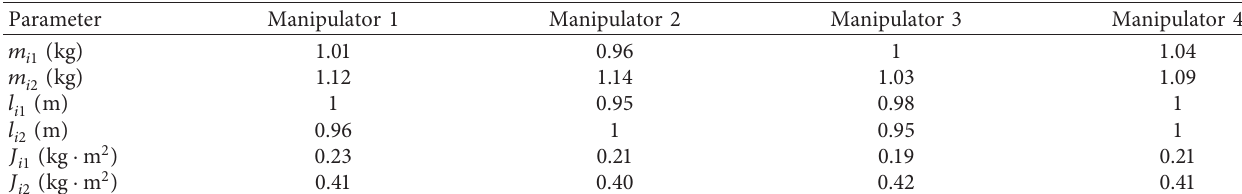
Table 2: The parameters of the robotic